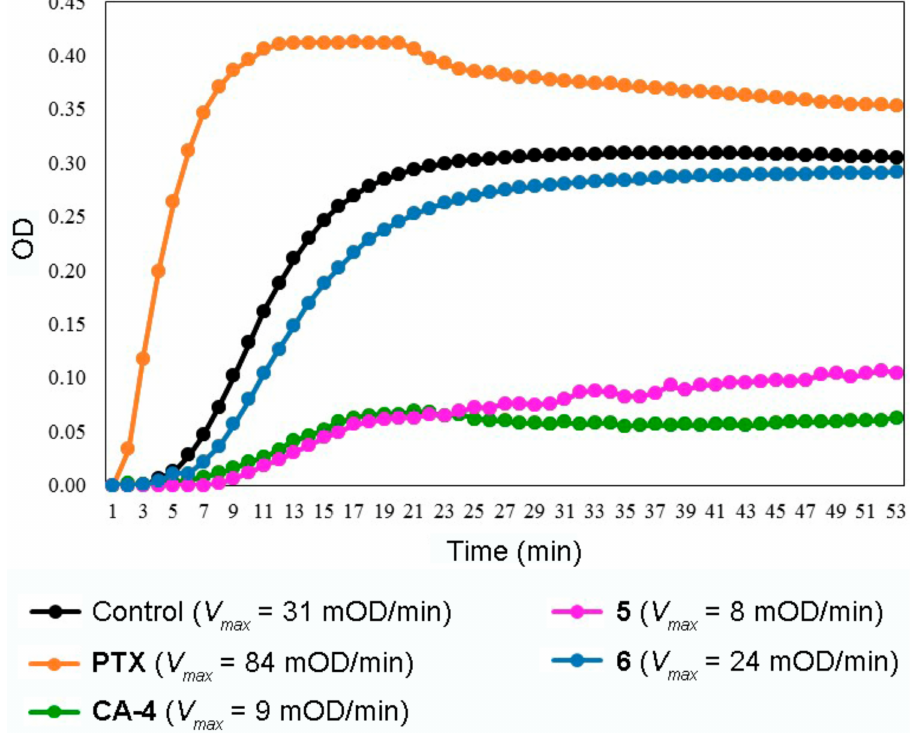
Figure 3. Effect of hybrid compounds 5 and 6 on tubulin polymerization. Polymerization reactions were carried out by incubation at 37 ◦ C and followed by absorbance readings at 340 nm for 53 min at 37 ◦ C. CA-4 and PTX were used as positive controls. All compounds were used at a final concentration of 10 µ